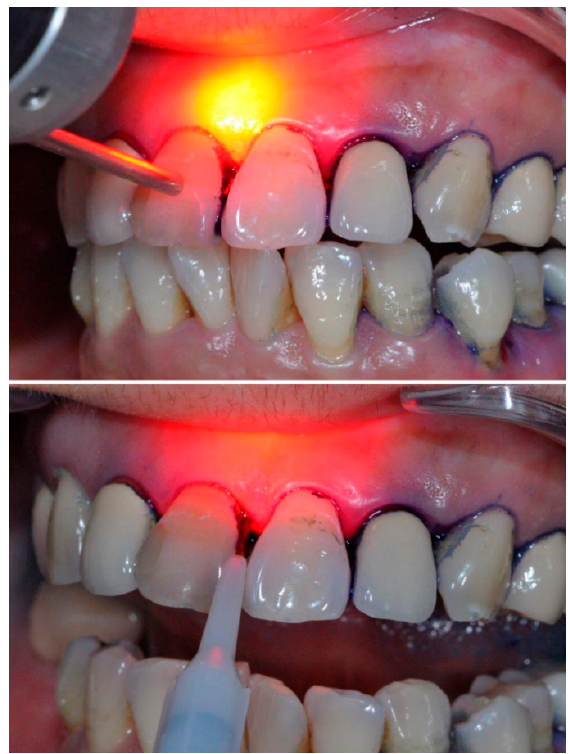
Figure 3. Photodynamic therapy (PDT) with toluidine blue O. Upper panel: Irradiation is correctly performed in non ‐ contact mode using a λ 628 nm red light laser source and an adjustable ‐ focus handpiece. Lower panel: Irradiation is performed in contact mode using the same λ 628 nm red light laser source and a Ø 800 μ m optic fiber inserted into the periodontal pockets: this procedure should be avoided because it can cause harm and bleeding and reduce the efficacy of PDT.